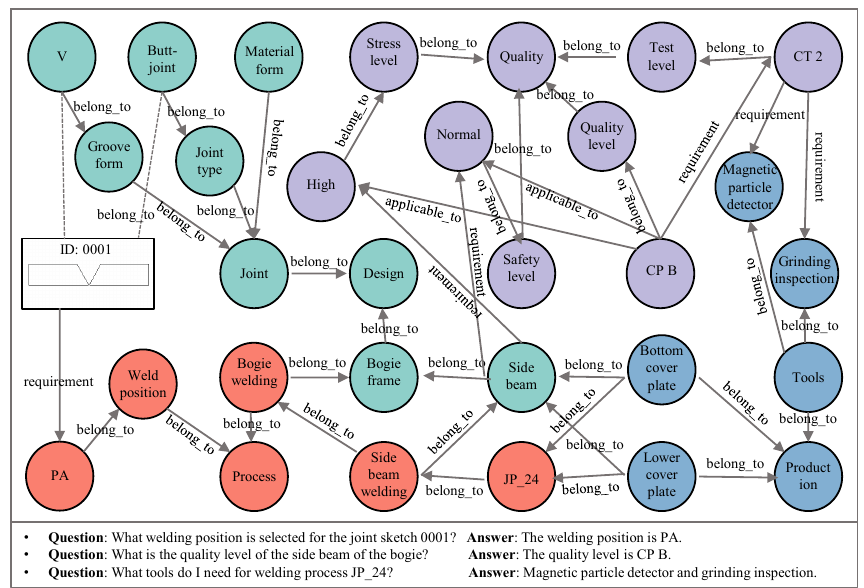
Figure 7. Welding process of the bottom cover plate and lower cover plate. The knowledge graph of the two components, which contains information about the design, process, quality, and production stages, is described. The figure lists intelligent question-and-answer data based on the process graph.